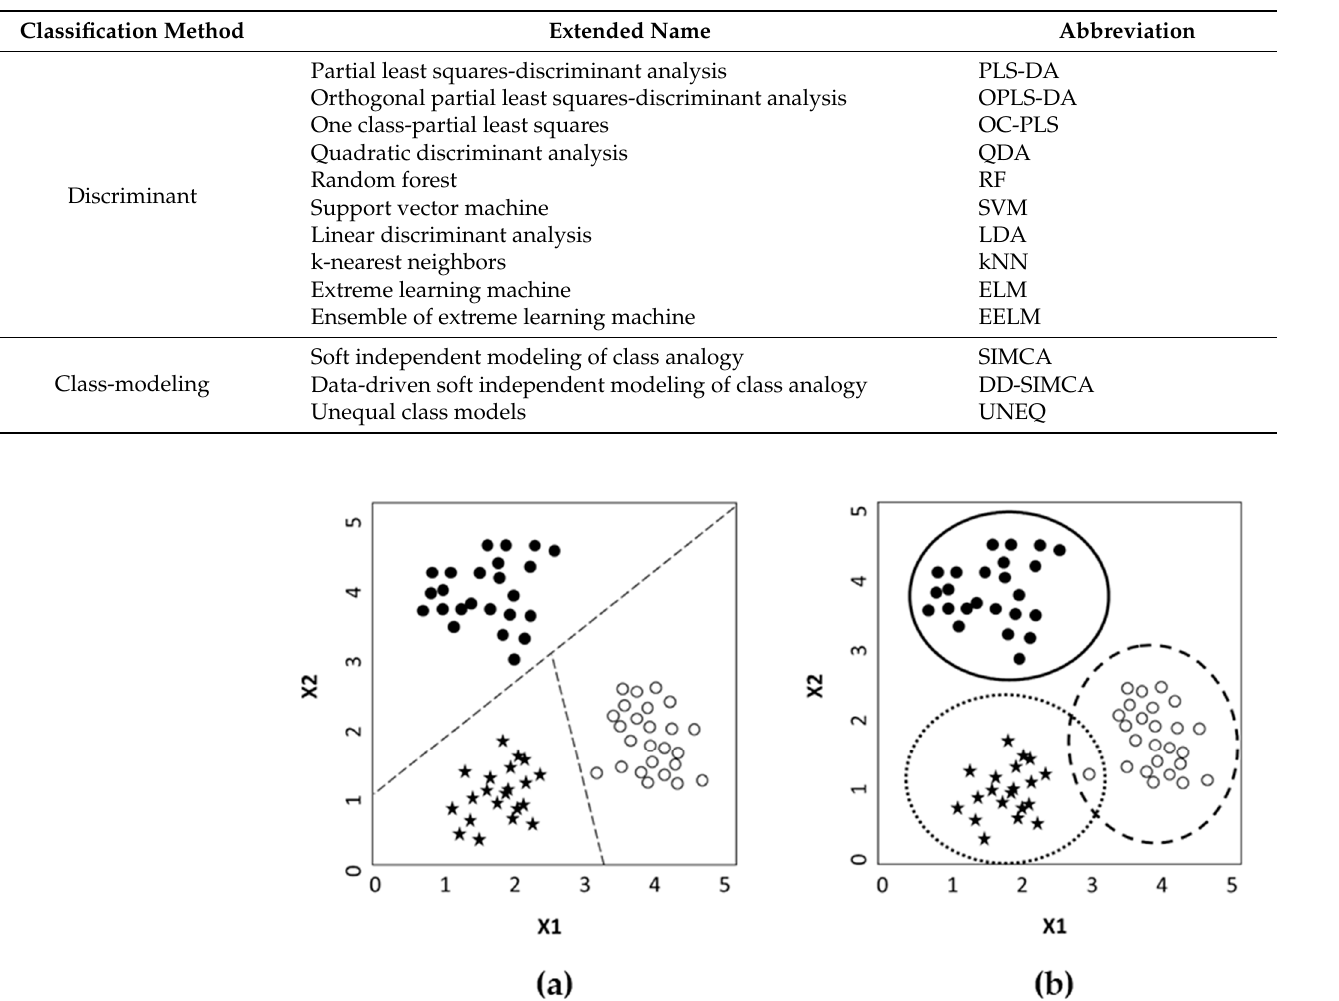
Table 2. Main classification methods cited.